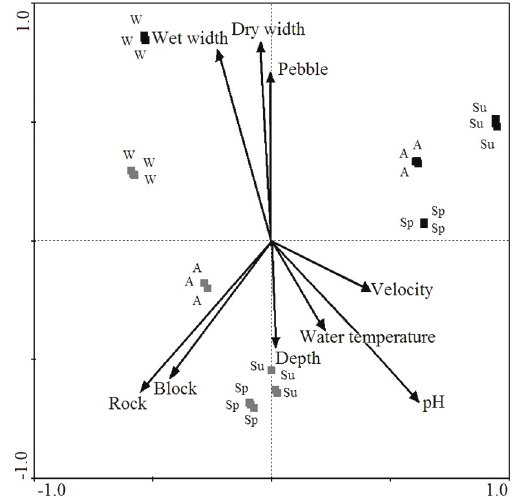
Figure 9. CCA ordination of benthic samples and abiotic variables in Achiras stream. Habitats: run ( ) and riffle ( ). Seasons: autumn (A), winter (W), spring (Sp) and summer (Su).